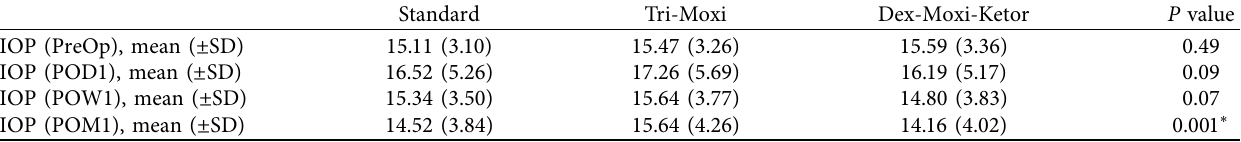
Table 5: Intraocular pressure comparison between different treatment groups at different time points.